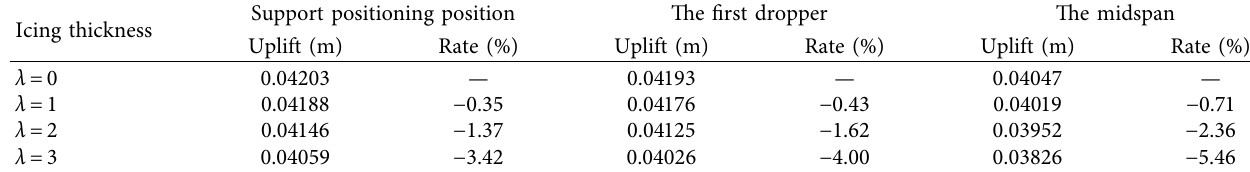
Table 6: Statistical value of uplift at different positions after icing (combinatorial material method). Support positioning position Icing thickness